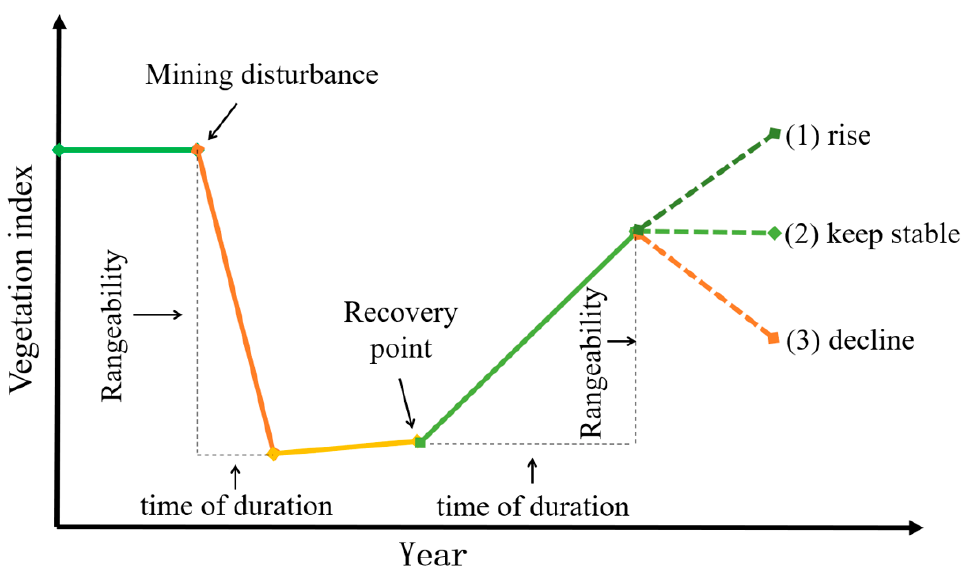
Figure 3. Vegetation disturbance and restoration process of open-pit mines.